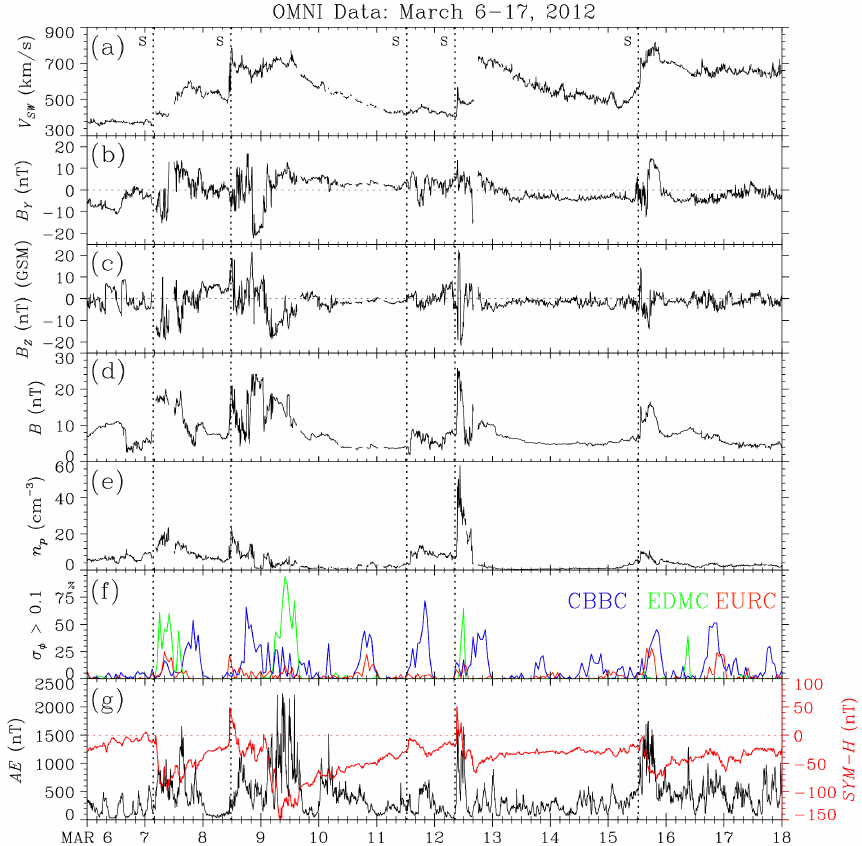
Figure 2. (a–e) The interplanetary data from the 5min OMNI data set. (f) The hourly occurrences of phase scintillation ( σ (cid:56) >0.1rad) observed by CHAIN stations in Cambridge Bay (CBBC), Eureka (EURC), and Edmonton (EDMC), and (g) provisional geomagnetic indices AE and